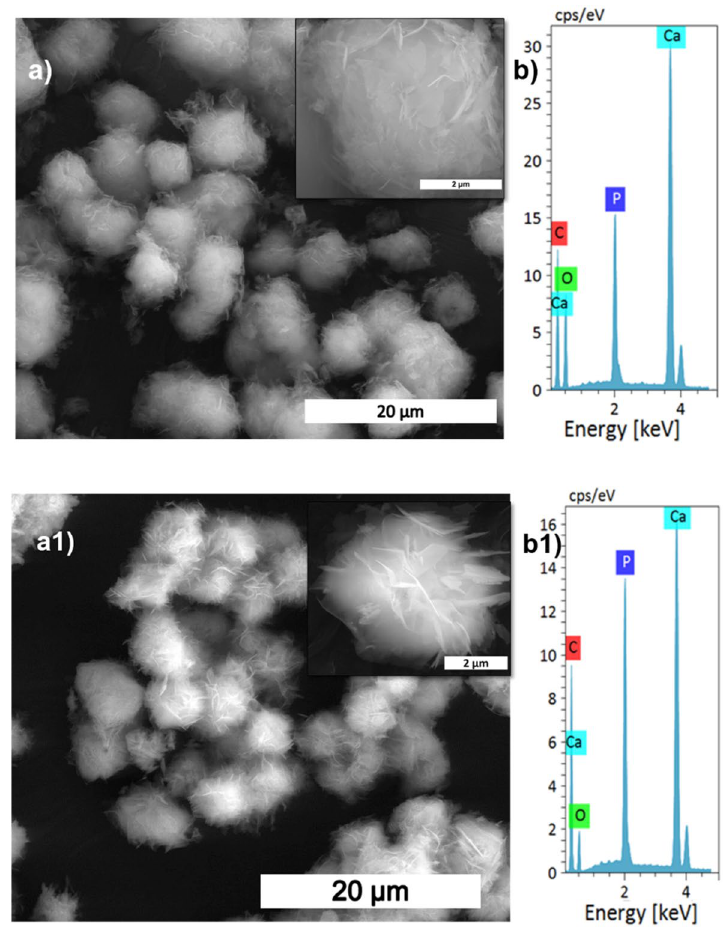
Figure 5. SEM analysis ( a,a1 ), and its magnified images (insert), with EDS spectrum ( b,b1 ) of S5, and S8 samples, respectively.